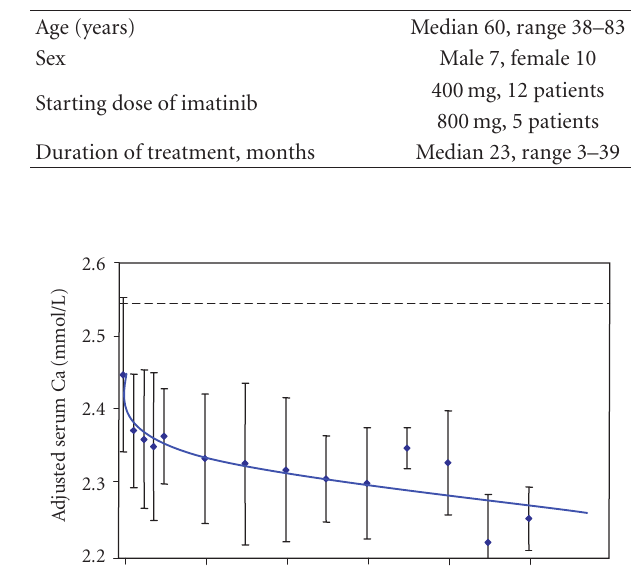
Table 2: Patient characteristics.